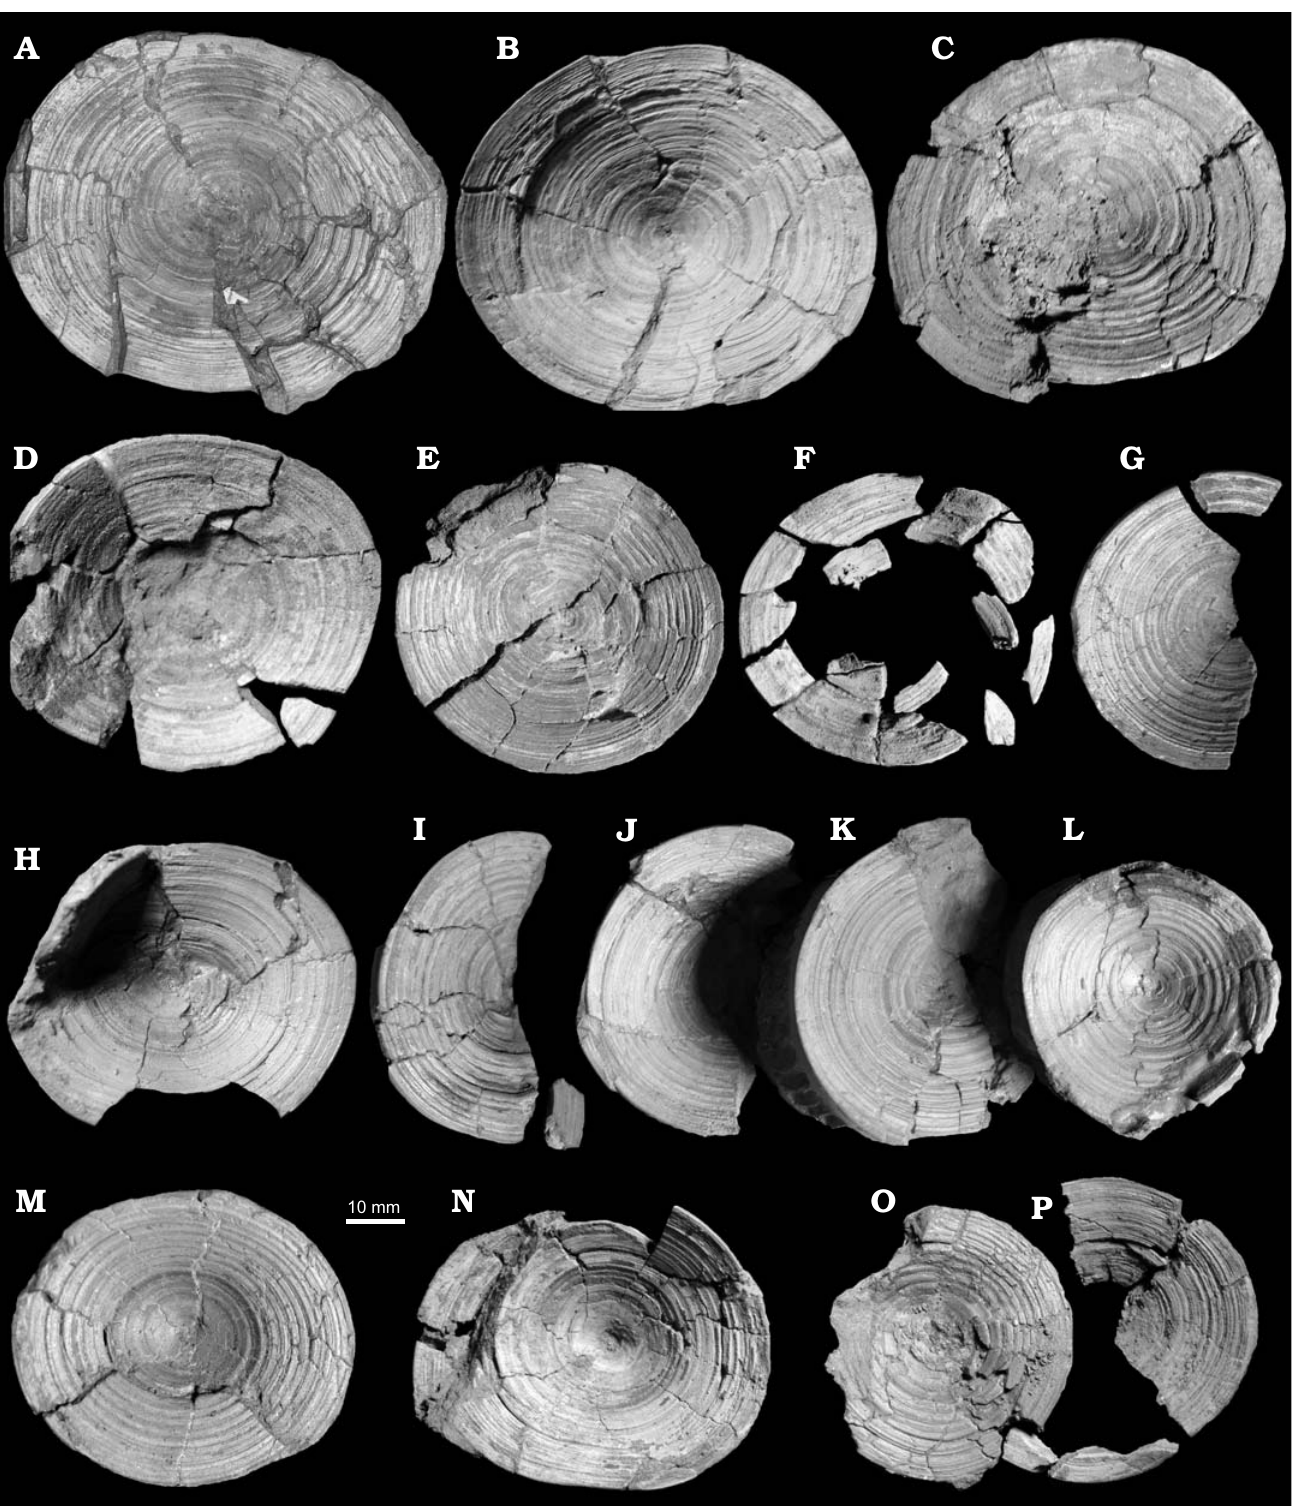
Fig. 5. Trunk vertebrae of the mackerel shark Carcharomodus escheri (Agassiz, 1843), MNU 071-20, from Groß Pampau, the middle–late Miocene, displaying the characteristic lamniform morphology and concentric growth bands from anterior ( A ) to posterior ( P